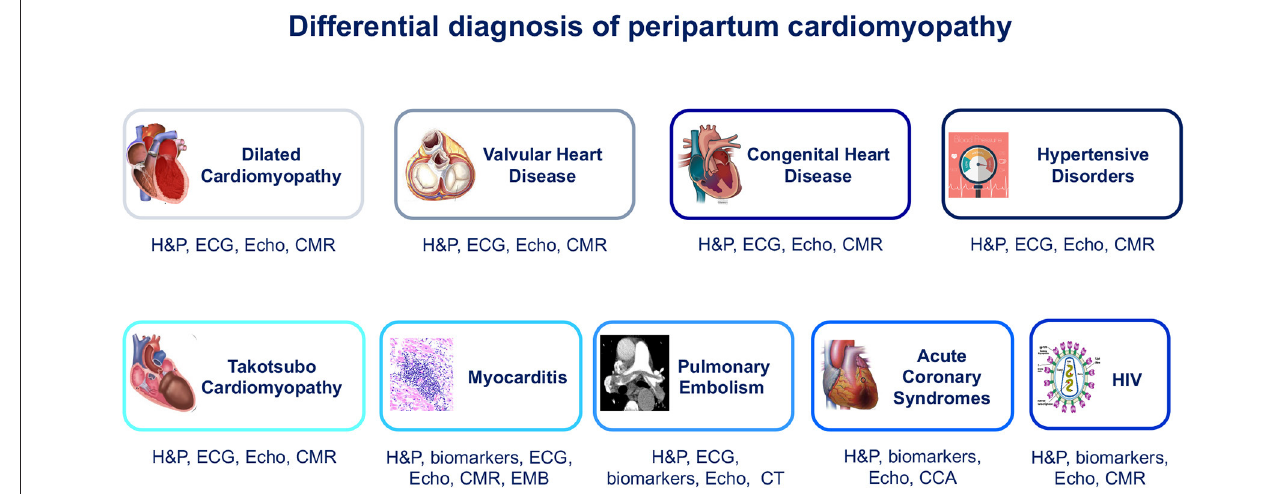
FIGURE 1 | Differential diagnosis of peripartum cardiomyopathy. CCA, conventional coronary angiography; CMR, cardiac magnetic resonance; CT, computed tomography; ECG, electrocardiogram; EMB, endomyocardial biopsy; H&P, history and physical examination; HIV, human immunodeficiency virus; VHD, valvular heart disease.